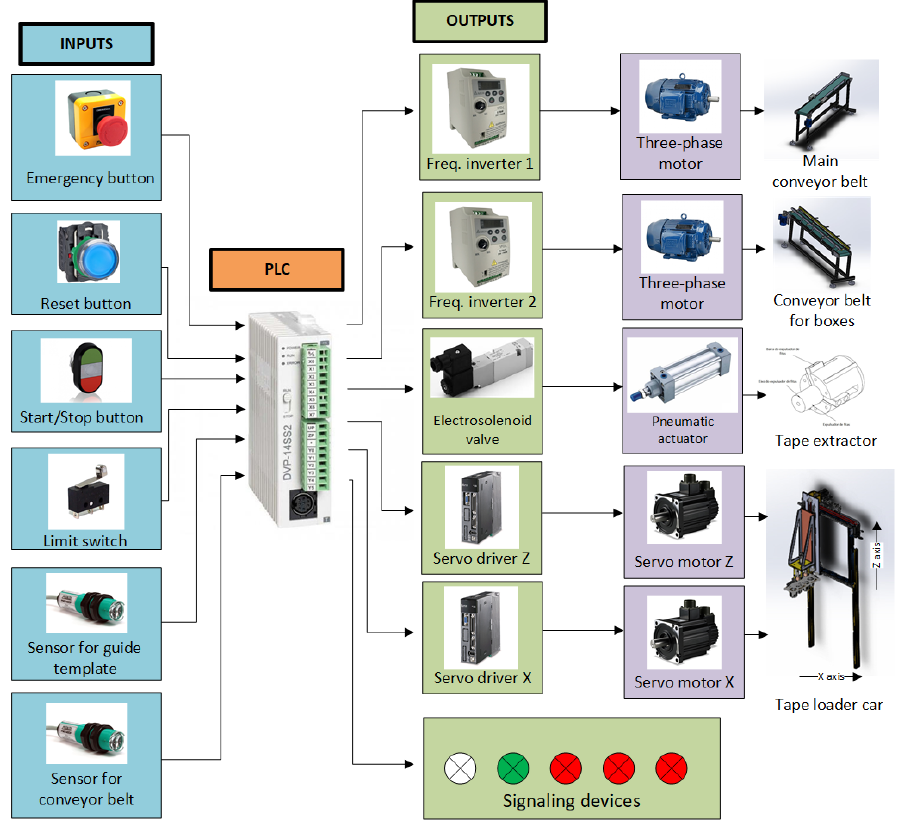
Figure 6. Architectural diagram of the electrical